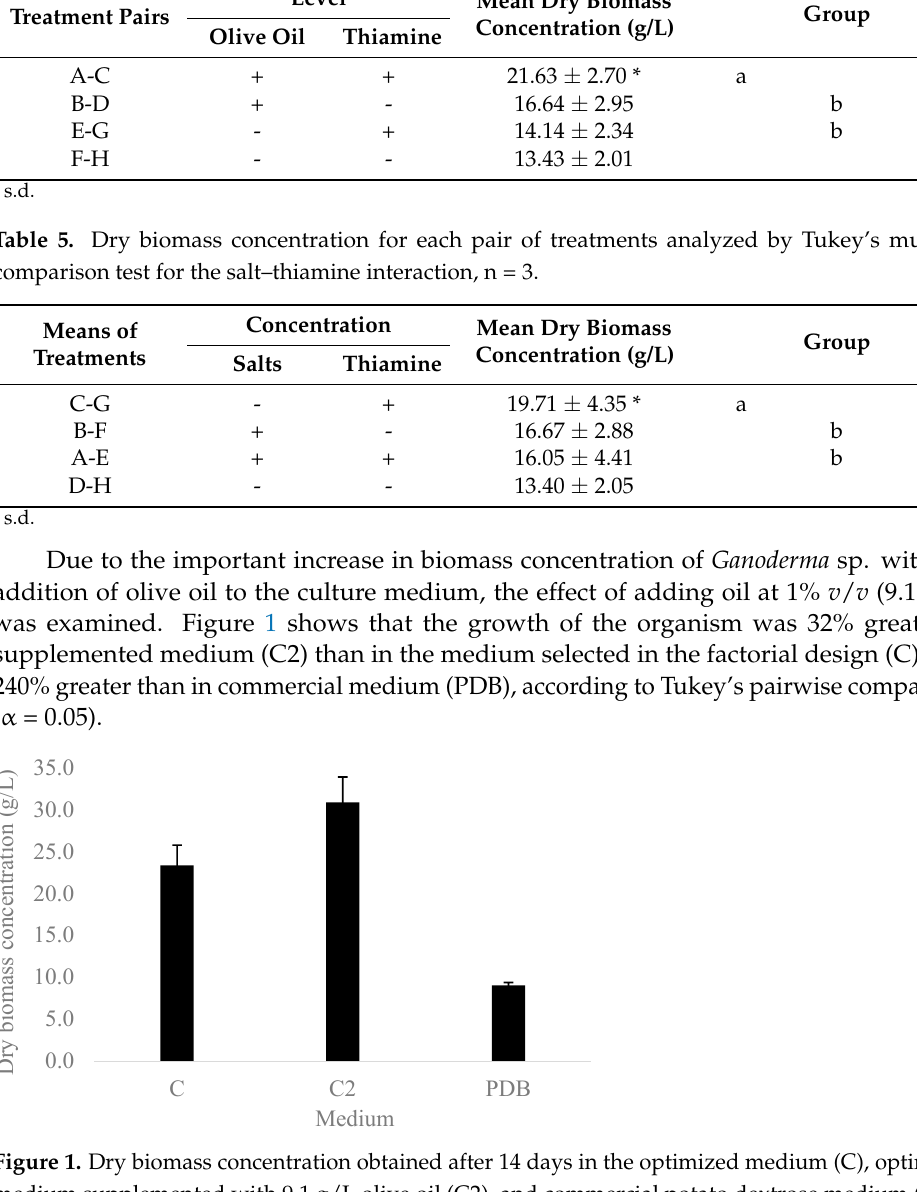
Figure 2. The effect of the inoculum method on the dry biomass weight of Ganoderma sp. mycelia. Other studies have shown that the size, homogeneity, and concentration of the in- oculum may affect the growth phases of this fungus. Researchers have used different in- oculation techniques for Ganoderma , but pre-inoculation is the most used [16]. Although biomass production was not significantly different among inoculation methods, pre- inoculation resulted in more homogeneous growth and better distribution and was therefore selected for use in later experiments. 3.2. Inoculum Concentration Figure 3 shows the effect of the inoculum concentration on the dry biomass concen- tration and growth index. The dry biomass concentration (black bars) tended to increase with increased inoculum concentration. In contrast, the growth index (striped bars) de-